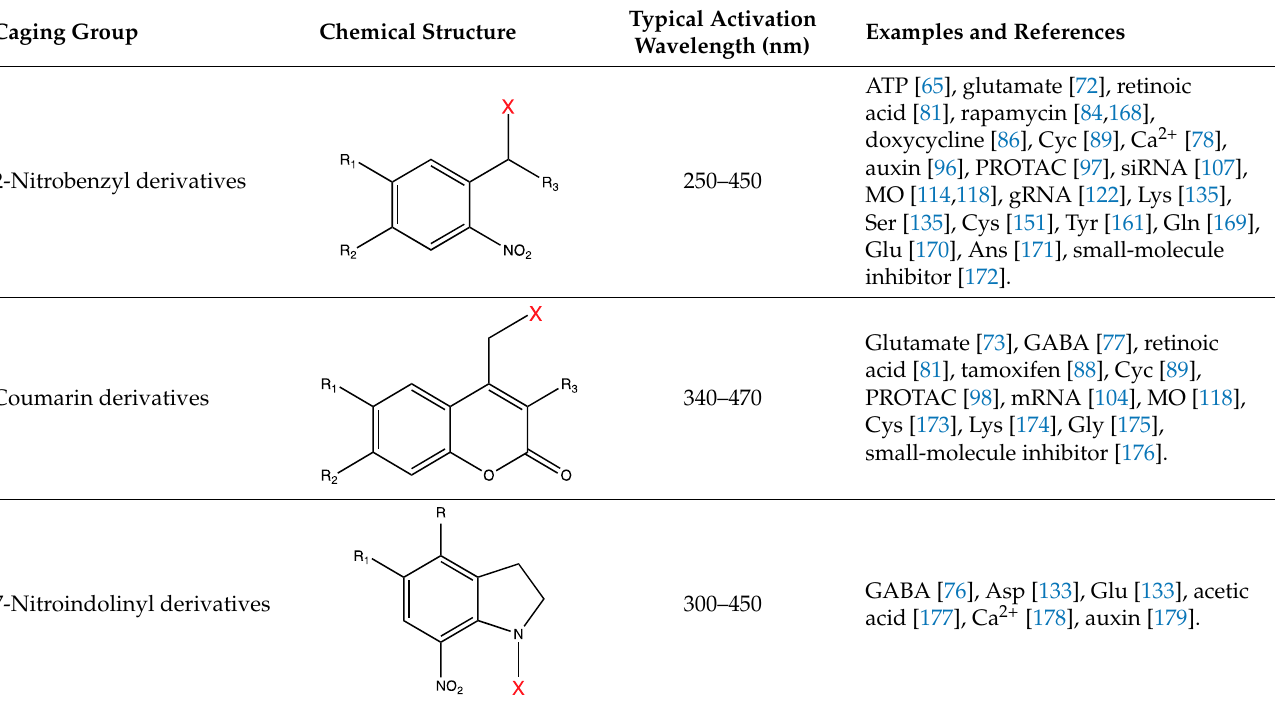
Table 1. Some common caging groups used in photocaging. Leaving groups (X) are colored red.